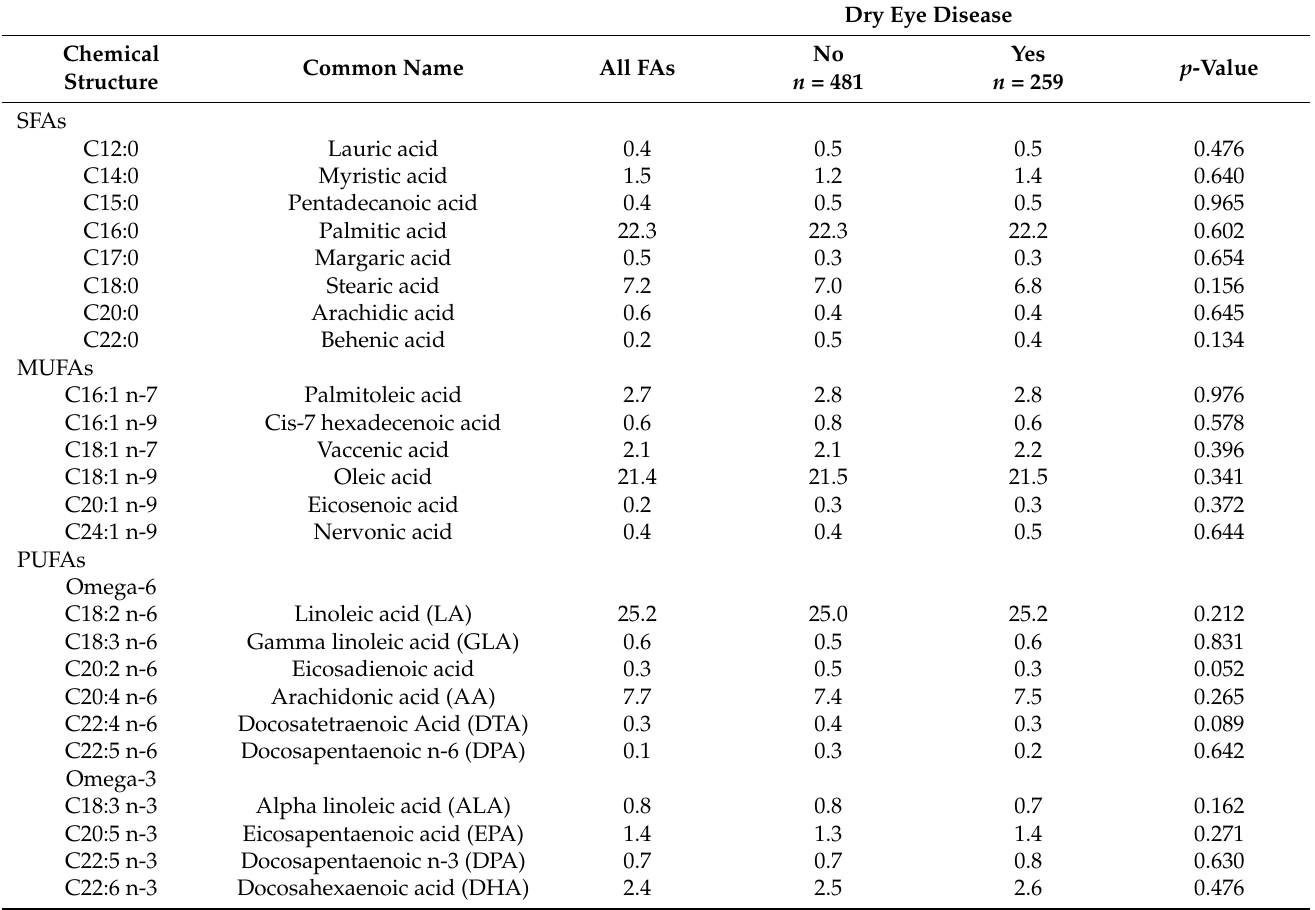
Table 3. Percentages of plasma fatty acids according to the presence of dry eye disease, n = 740. Dry Eye